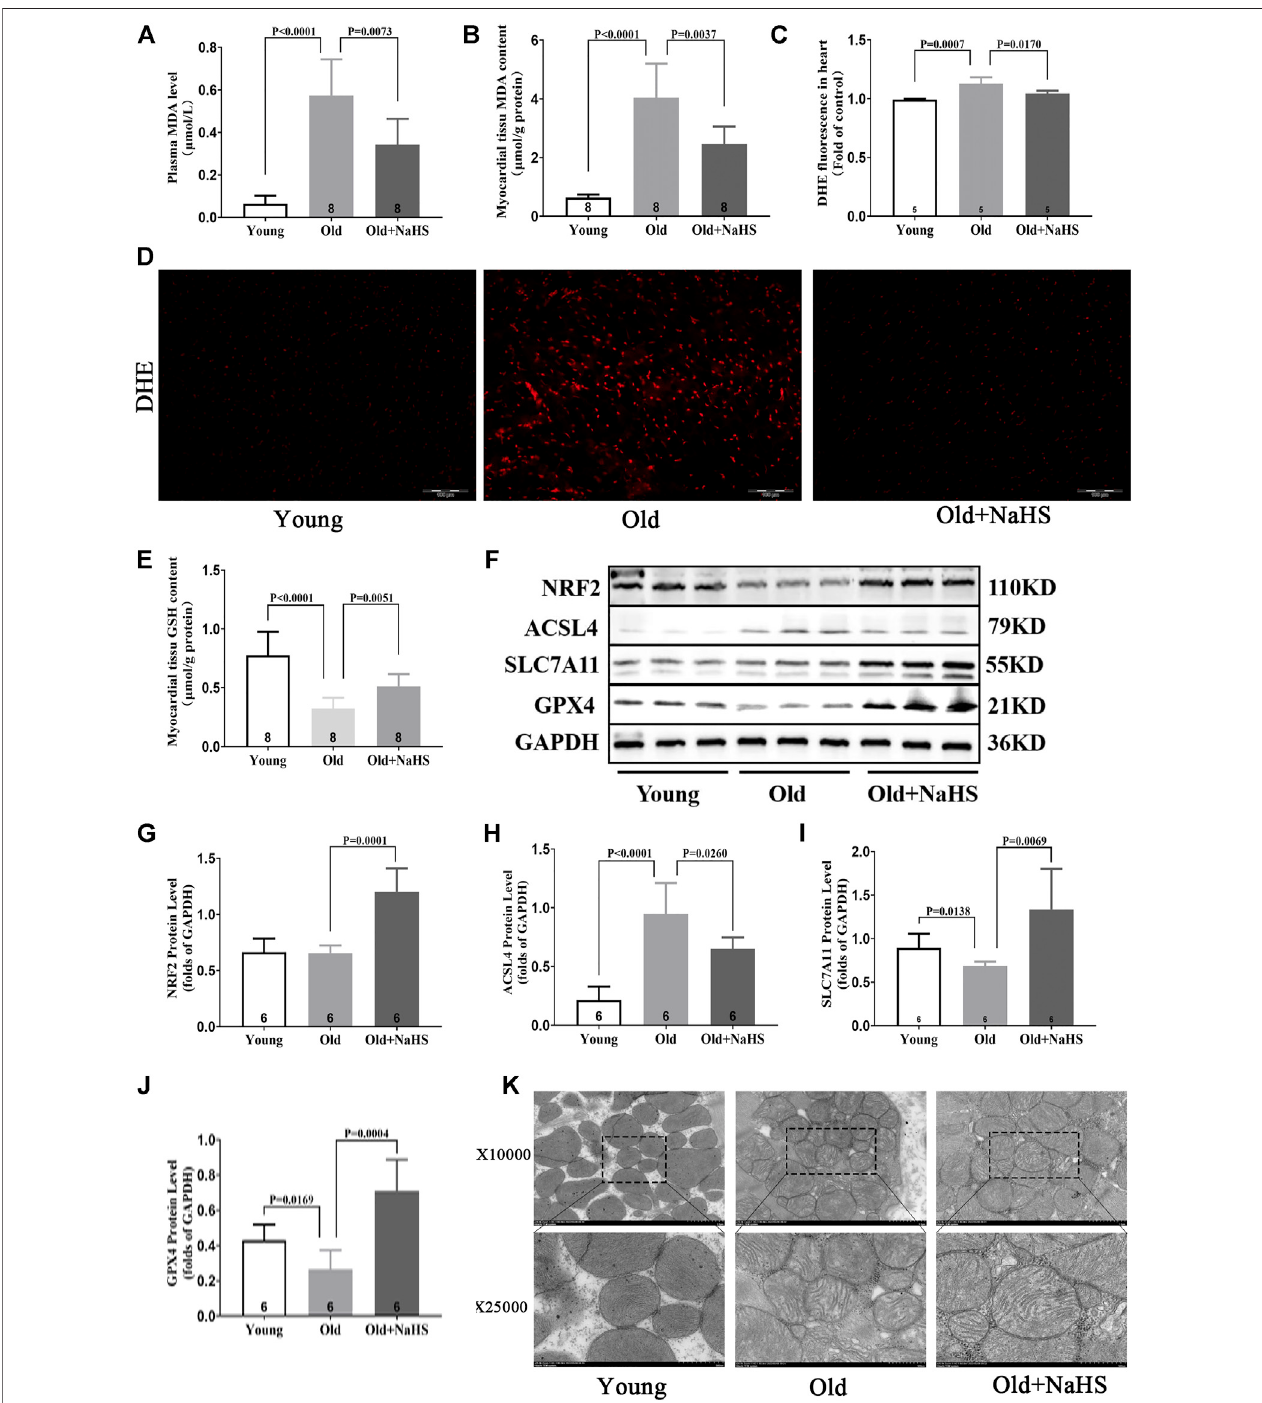
FIGURE 7 | H 2 S inhibited cardiomyocyte ferroptosis in aging rats. (A) MDA levels in the plasma of aging rats. (B) MDA levels in the myocardial tissue of aging rats. (C) Quantitative data on DHE- fl uorescence in aging rats. (D) Representative DHE- fl uorescence in the myocardial tissue sections of aging rats. (E) GSH levels in the myocardial tissue of aging rats. (F) Representative Western blots for NRF2, ACSL4, SLC7A11, and GPX4 expressions in the myocardial tissues of aging rats. GAPDH was used as the internal control. (G) The quantitative analysis for NRF2 expression in the myocardial tissue of aging rats. (H) Quantitative analysis for ACSL4 expression in the myocardial tissue of aging rats. (I) Quantitative analysis for the SLC7A11 expression in the myocardial tissue of aging rats. (J) Quantitative analysis for the GPX4 expression in the myocardial tissue of aging rats. (K) Representative images of transmission electron microscopy for mitochondria in the cardiomyocyte of aging rats. Results are means ± SEM. A p -value of < 0.05 was considered signi fi cant.